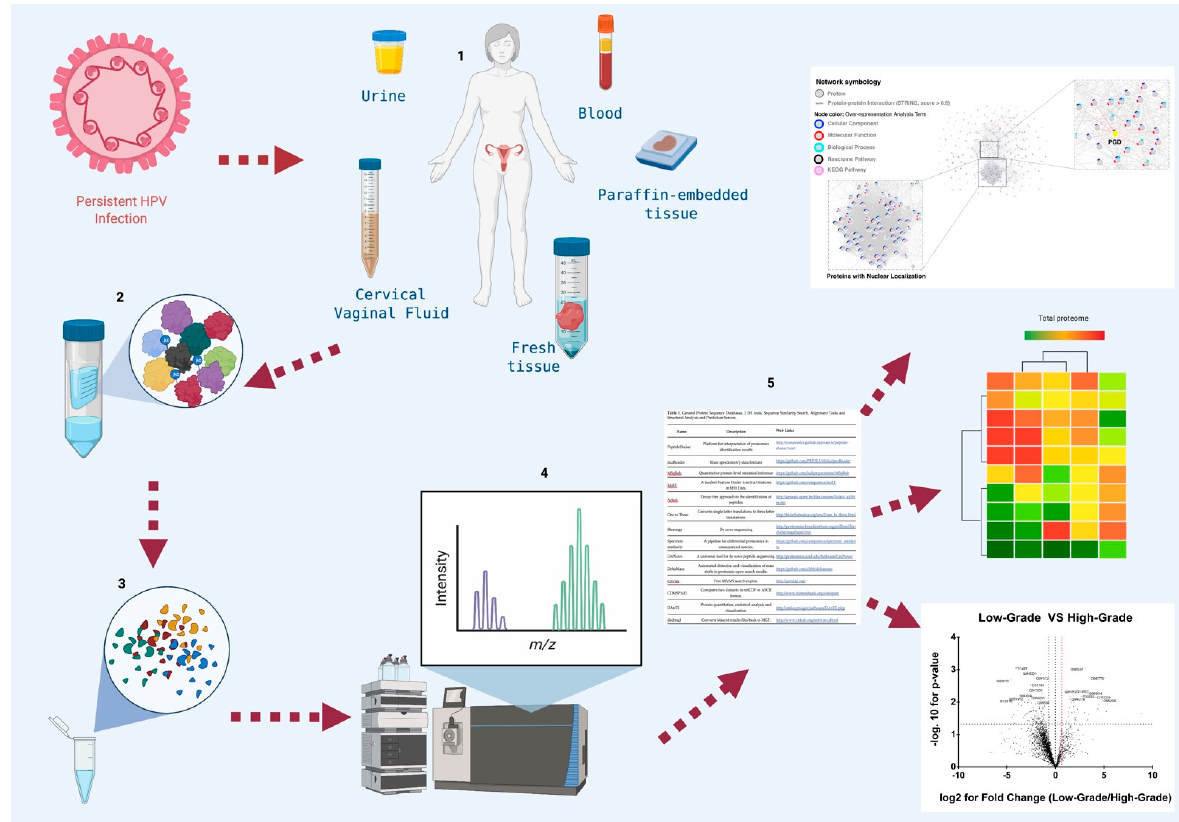
Figure 1. General diagram of the workflow in proteomic studies in cervical cancer. Proteomic studies in cervical cancer are designed to search for biomarkers that could be used in the diagnosis, prognosis, and identification of new therapeutic targets, and they are carried out Figure 1. (1) Collection of biological samples from patients and controls such as: urine, vaginal cervical fluid, blood, and tumor tissue. If the samples start from cells, it is essential to perform cell lysis or mechanical destruction (freeze thaw, French press, sonication macerated with liquid N 2 , lysis with detergents). (2) Purification of total proteins by centrifugation. The storage of the sample until its use at temperatures of − 20 °C or − 70 °C with or without protease inhibitor according to the chosen step of proteomic analysis to avoid any interference with the selected method. (3) Proteomic strategy selection, based on advanced techniques: protein microarray, mass spectrometry, Edman sequencing, 2D gel, 2D-DIGE. Quantitative techniques: ICAT, SILAC, iTRAQ. High throughput techniques: X-ray crystallography, NMR spectroscopy. (4) Match in databases and validation of candidates by ELISA, Western Blot or Immunohistochemistry. (5) Graphics construction. Partially created with BioRender.com.